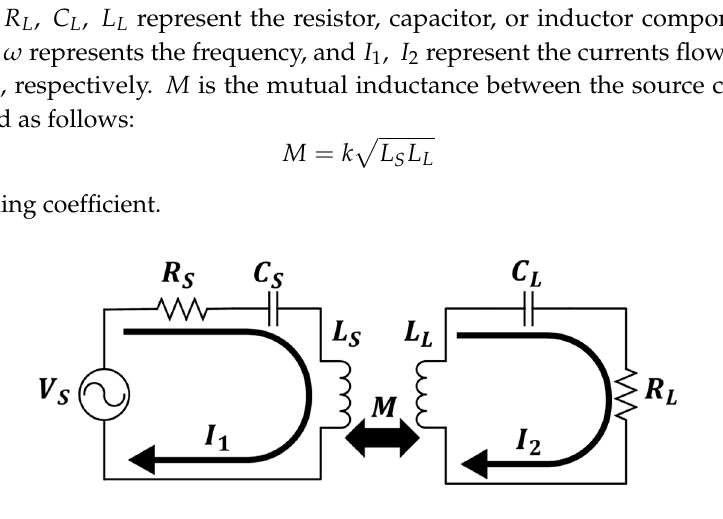
Figure 3. General circuit model for wireless power transfer (WPT).